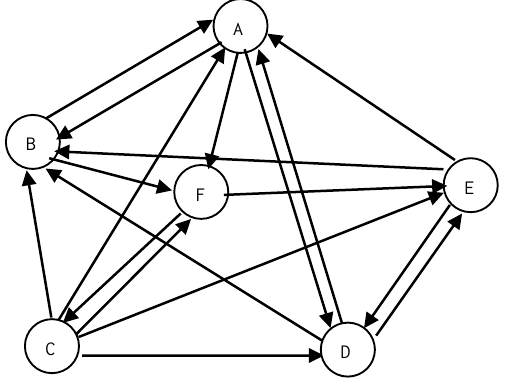
Figure 2. An example of directed social network.